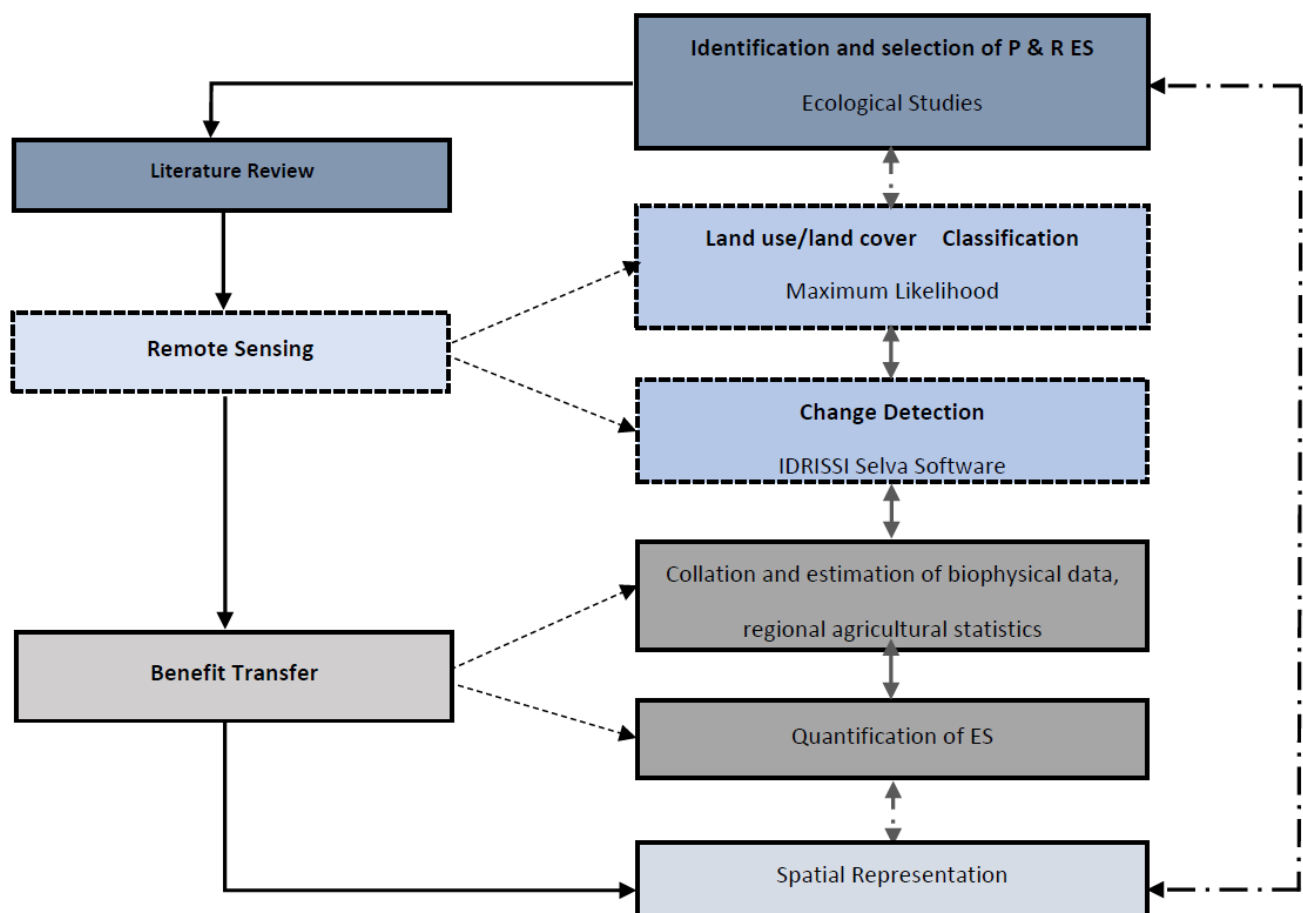
Figure 2. Methodological framework for assessing land use impacts on coastal ES in Southwestern Ghana .